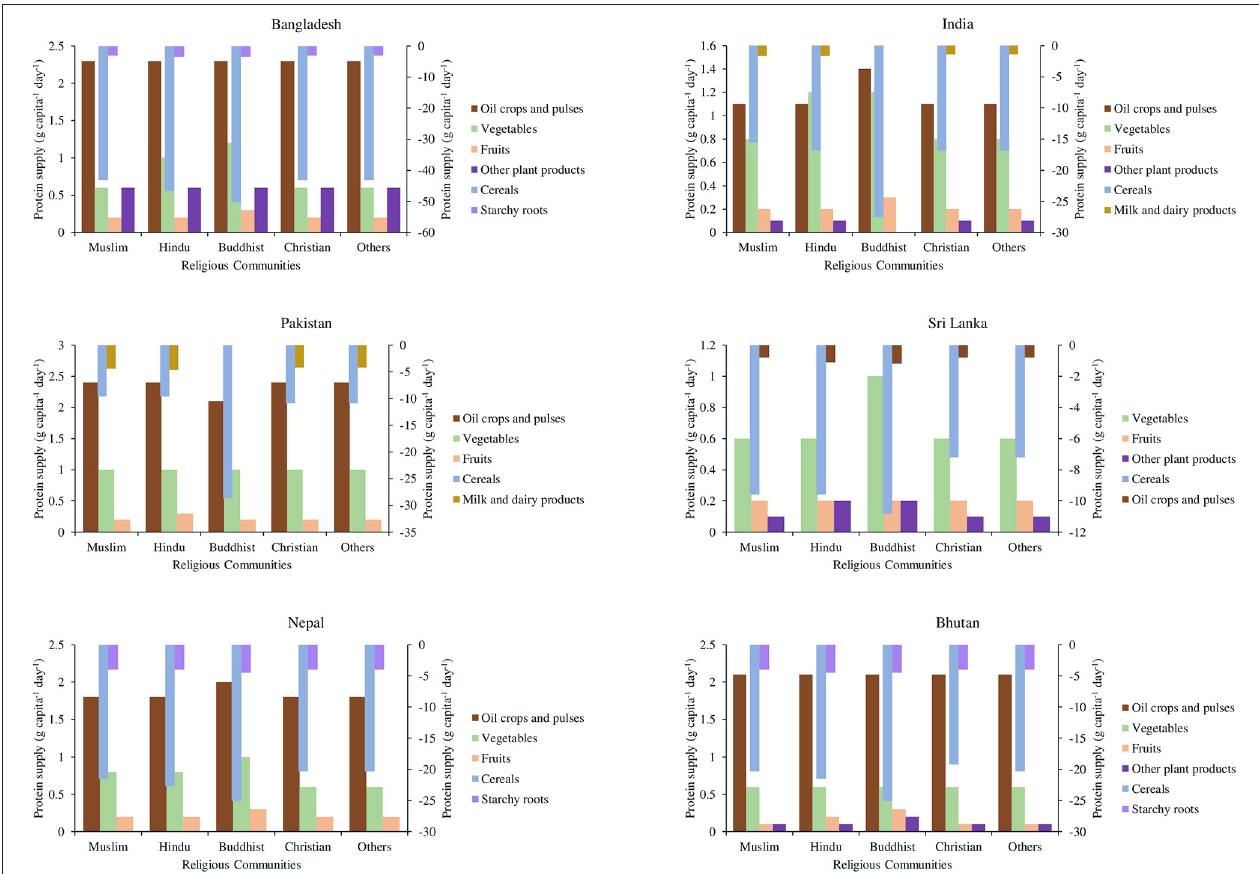
FIGURE 1 | Recommended religion-sensitive alterations in protein supply relative to 2013 protein supply base. Positive values indicate increase and negative values indicate decrease in protein supply.